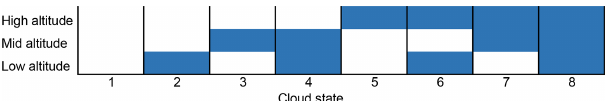
Figure 17. The cloud states used in the following figures. The shad- ing indicates the presence of low-, mid- or high-altitude clouds (see text for the definitions of this) as determined by requiring the model cloud fraction to be larger than 0.01. Cloud state no. 1 is clear